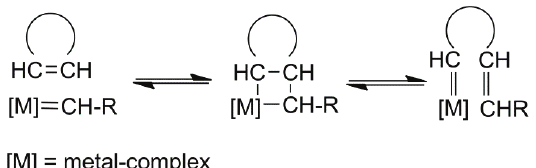
Figure 55. The mechanism of ROMP including the metallocyclobutane